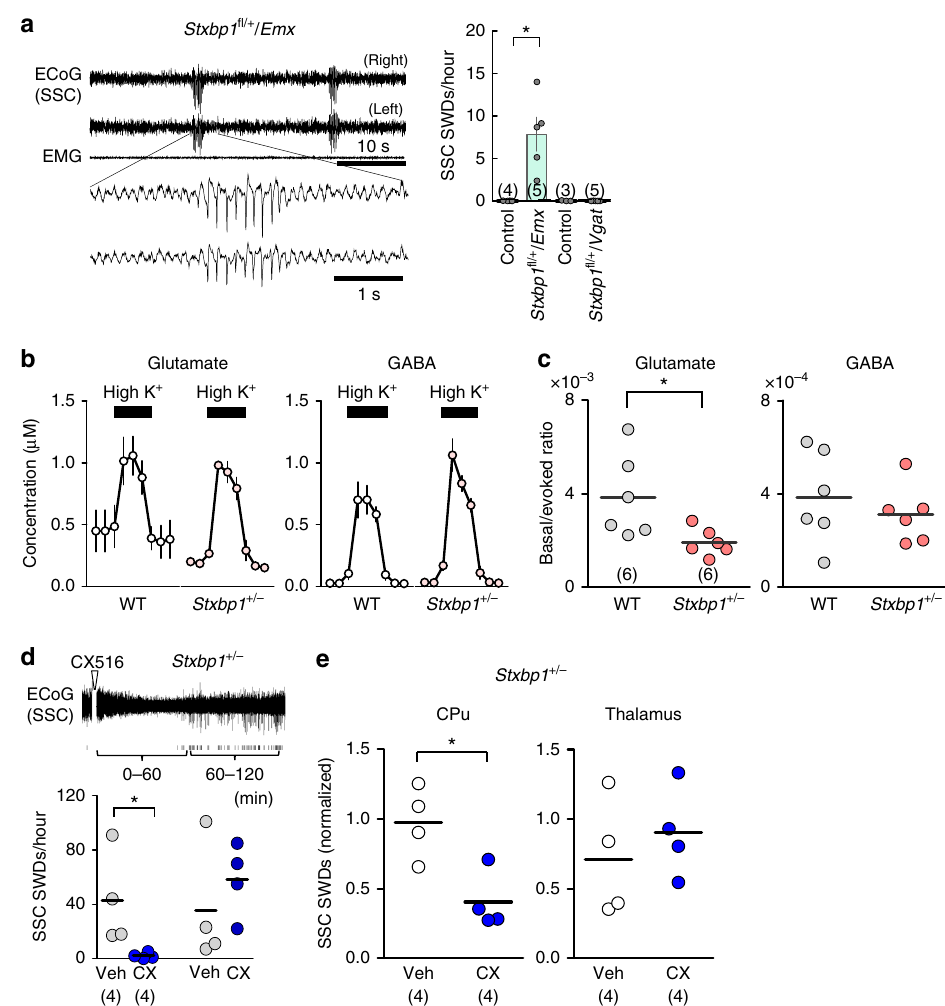
Fig. 3 Impaired cortico-striatal excitatory transmission underlies SWDs in Stxbp1 + / − mice. a SWDs appeared in Stxbp1 fl / + / Emx , but not in Stxbp1 fl / + / Vgat mice. (Left) Representative SWDs in an Stxbp1 fl / + / Emx mouse. (Right) Number of SSC SWDs (24 h recording). Stxbp1 fl / + / Emx ( N = 5), littermate controls (1 WT, 2 Stxbp1 fl / + , 1 Stxbp1 + / + / Emx , N = 4); Stxbp1 fl / + / Vgat ( N = 5), littermate controls (1 WT, 2 Stxbp1 fl / + , N = 3). Mann – Whitney U test, control vs. Stxbp1 fl / + / Emx : * P = 0.0286; control vs. Stxbp1 fl / + / Vgat : P = 0.8255. b Glutamate and GABA release in the CPu of freely behaving WT ( N = 6) and Stxbp1 + / − ( N = 6) mice with high K + stimulation. c Basal glutamate release (normalized by high K + -evoked release), but not GABA release, was signi fi cantly lower in Stxbp1 + / − mice. Mann – Whitney U test, WT vs. Stxbp1 + / − , glutamate: * P = 0.026; GABA P = 0.5887. d Potentiation of AMPA receptors in the CPu suppressed SWDs in Stxbp1 + / − mice. (Top) Representative SSC-ECoG after intraperitoneal injection of the ampakine, CX516. Tick marks represent SWDs. (Bottom) SWDs were suppressed in the fi rst, but not in the second, 60 min following CX516 intraperitoneal injection. Stxbp1 + / − mice ( N = 4), vehicle vs. CX516, signi fi cant in the fi rst but not the second 60 min period (Mann – Whitney U test, vehicle vs. CX516, 0 – 60 min: * P = 0.0268; 60 – 120 min: P = 0.4857). e CX516 injection into the CPu, but not the thalamus, suppressed SWDs (3000s recording after injection, normalized,